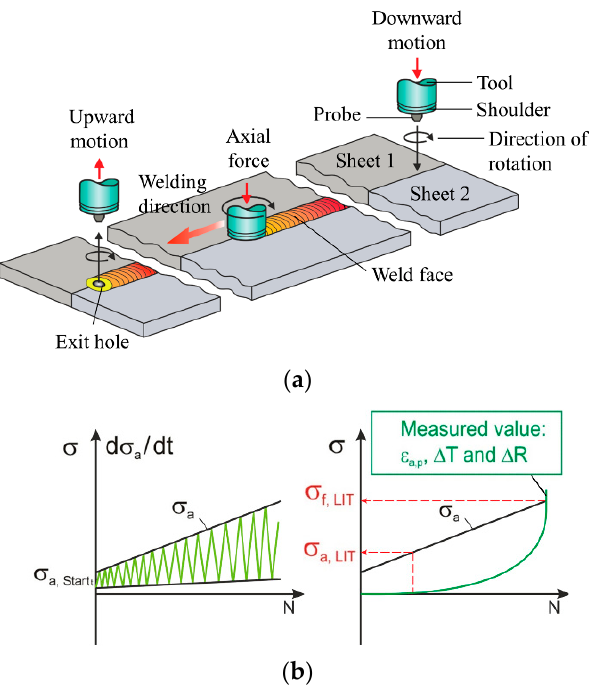
Figure 1. ( a ) Operating principle of friction-stir welding (FSW); ( b ) characteristics of the continuous load increase test (LIT).